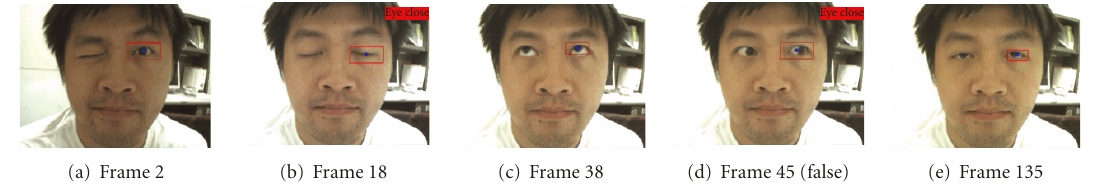
Figure 3: Examples of the blink detection results for indoor videos. Red boxes are tracked eyes, and the blue dots are the center of the eye locations. The red bar on the top-left indicates the presence of closed